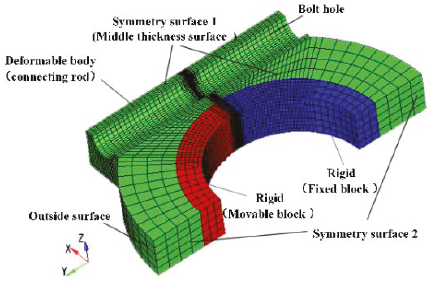
Figure 5. Model diagram.